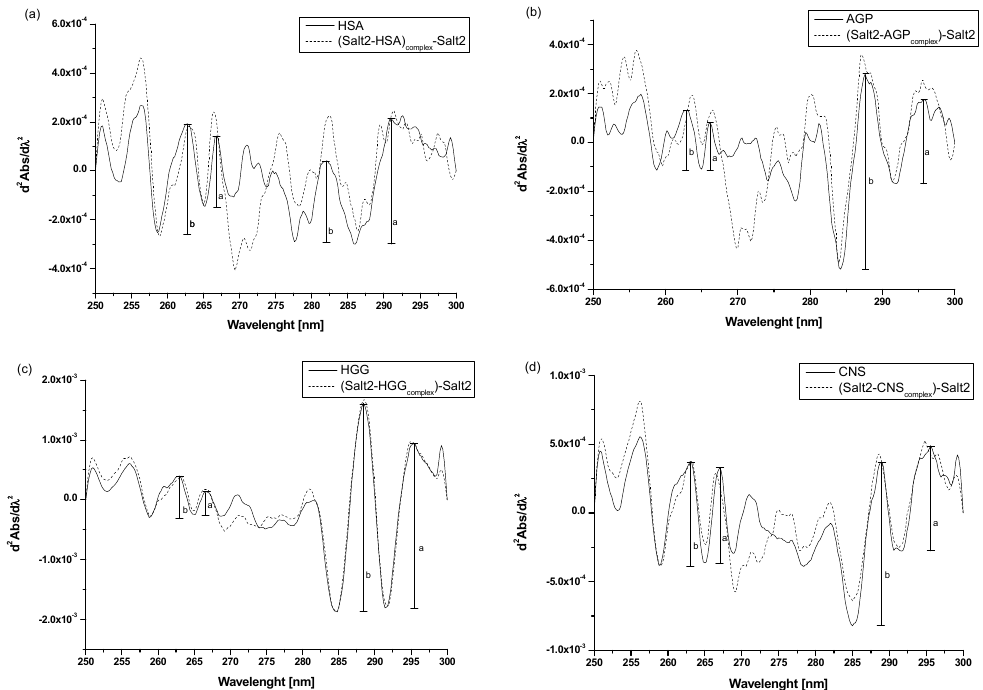
Figure 3. Second derivative absorption spectra of ( a ) HSA vs. (Salt2-HSA complex )-Salt2, ( b ) AGP vs. (Salt2-AGP complex )-Salt2, ( c ) HGG vs. (Salt2-HGG complex )-Salt2, ( d ) CNS vs. (Salt2-CNS complex )-Salt2 after subtraction of Salt2 absorption, respectively. [Proteins concentration] 3 × 10 − 6 mol · L − 1 ; [Salt2]:[HSA] 7:1 molar ratio, [Salt2]:[AGP] 8:1 molar ratio, [Salt2]:[HGG] 7:1 molar ratio, [Salt2]:[CNS] 7:1 molar ratio; a, b—peaks height.